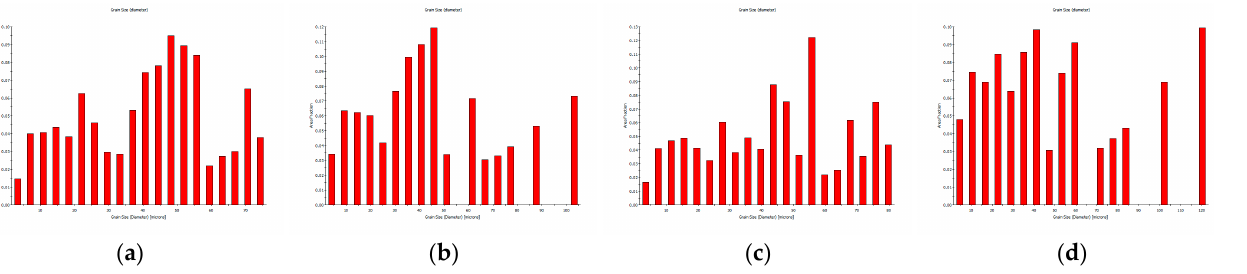
Figure 9. XRD pa tt erns of the sample after fracture at di ff erent aging temperatures.